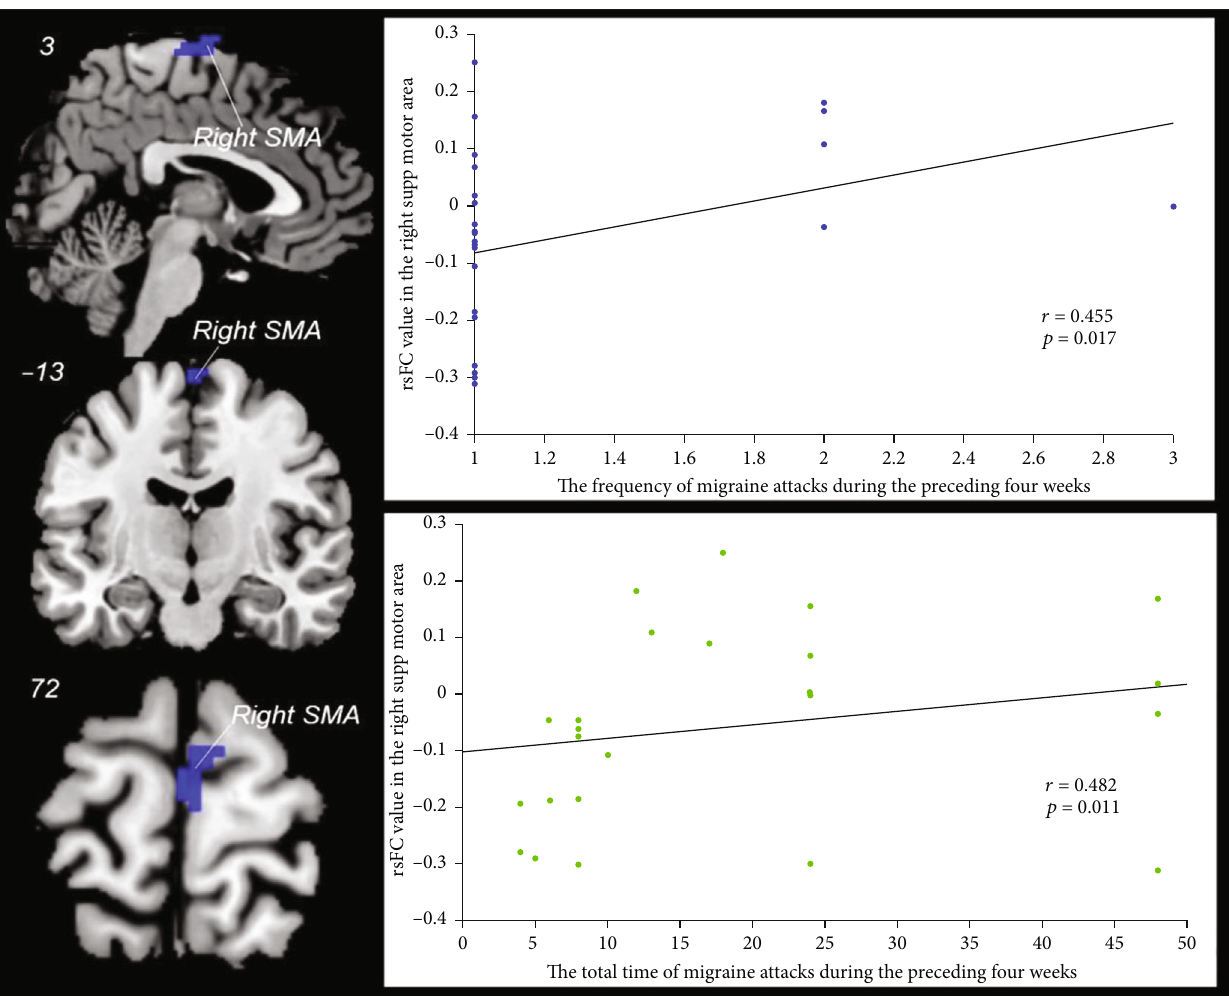
Figure 5: Correlation analysis between migraine attacks and the functional connectivity (FC) of the left amygdala during taVNS. SMA: supplementary motor area; rsFC: resting-state FC; supp: superior. The FC between the left amygdala and the right SMA was correlated with the frequency ( p = 0 : 017 and r = 0 : 455 ) and the total time ( p = 0 : 011 and r = 0 : 482 ) of migraine attacks during the preceding four weeks. Table 3: The functional connectivity results using the right amygdala as a seed in 27 MwoA patients. Contrast Cluster Brain region Peak T value Peak Z value Real > sham No brain region above the threshold Real < sham